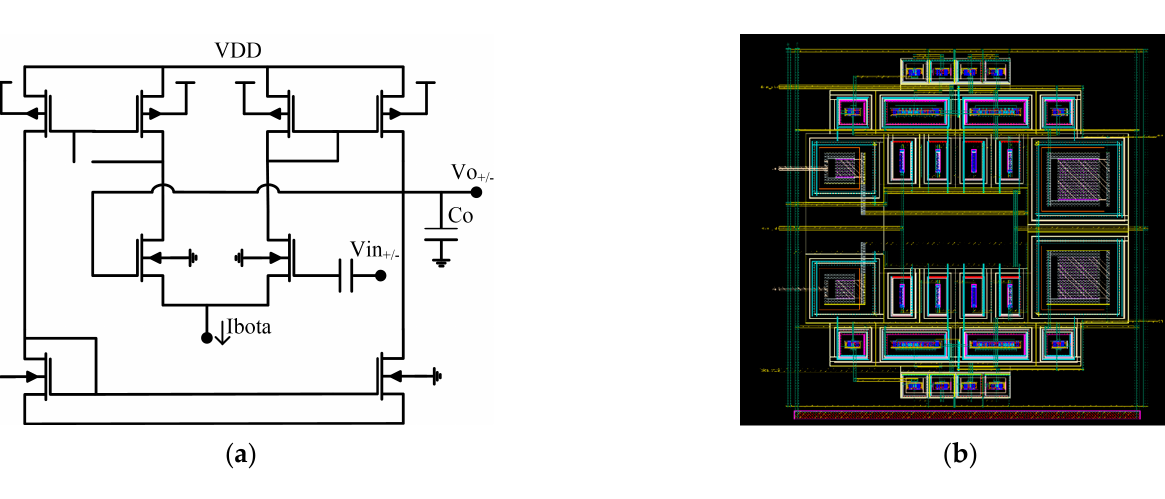
( b ) Figure 9. ( a ) Mixer schematic; and ( b ) implemented layout. Figure 10. Mixer conversion gain versus the intermediate-frequency f IF .